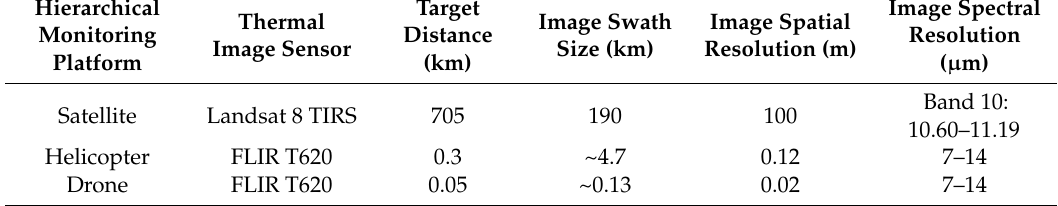
Table 1. Hierarchical monitoring platforms of satellite, helicopter, and drone, with the associated thermal image sensor, target distance, swath size, spatial resolution, and spectral resolution.